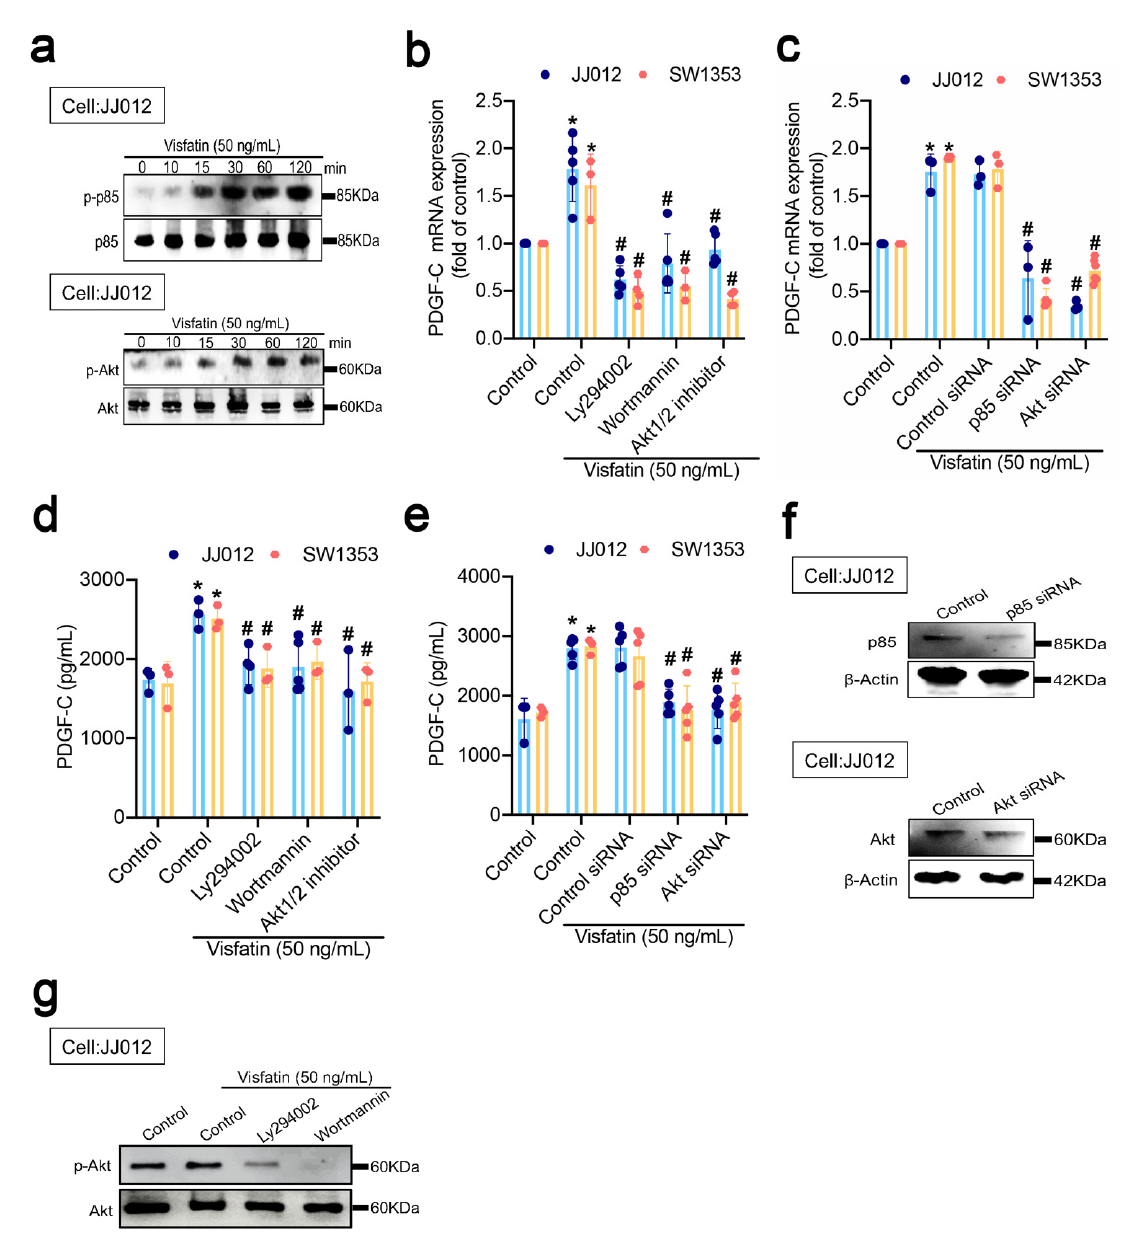
(Figure 4b–f). PI3K and Akt1/2 inhibitors significantly abolished visfatin-induced increases in mTOR phosphorylation (Figure 4g). Thus, visfatin appears to increase PDGF-C synthesis in chondrosarcoma cells through PI3K/Akt/mTOR signaling.